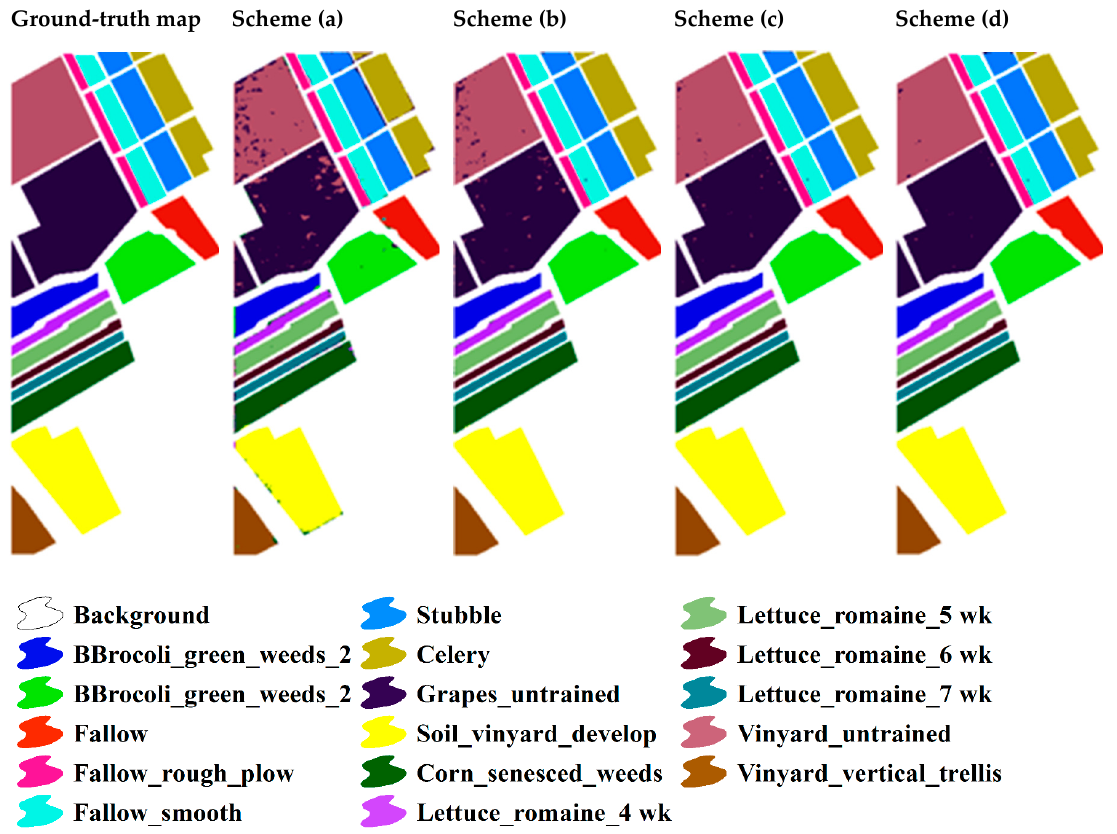
Figure 9. Classification results of the HDCA for the Salinas dataset. Scheme ( a ) 1% ( b ) 5%, ( c ) 10%, ( d ) 12.5% of the training samples of each class were used to classify the reference datasets.